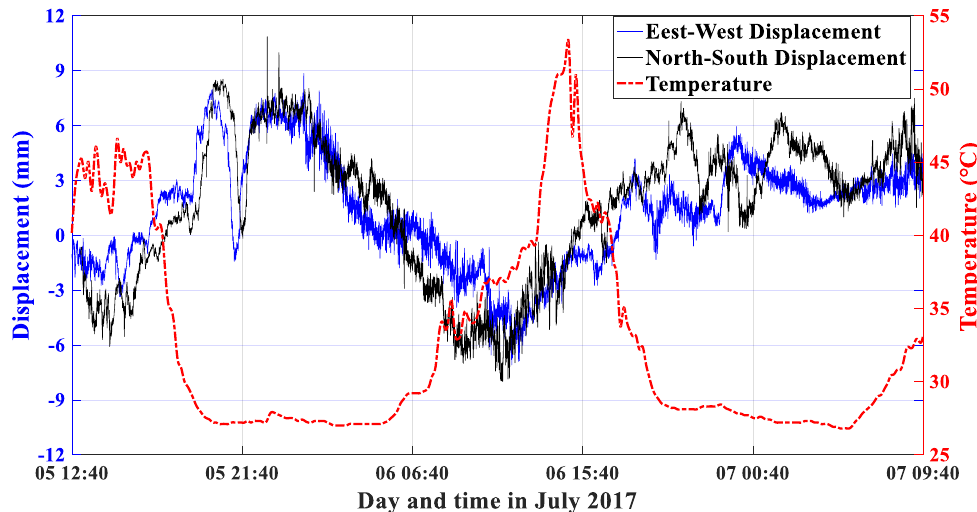
Figure 12. Displacement time series in east–west ( blue line ) and north–south ( black line ) directions versus temperature changes ( red dotted line ) at the roof of the WGC.